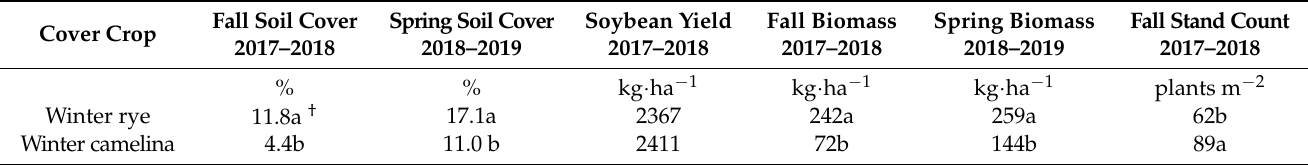
Table 11. Mean fall and spring cover crop soil coverage, cover crop biomass, and cover crop stand count readings for two cover crops averaged across five environments at Fargo and Casselton, ND, 2017, 2018, and 2019. Fall Soil Cover Cover Crop